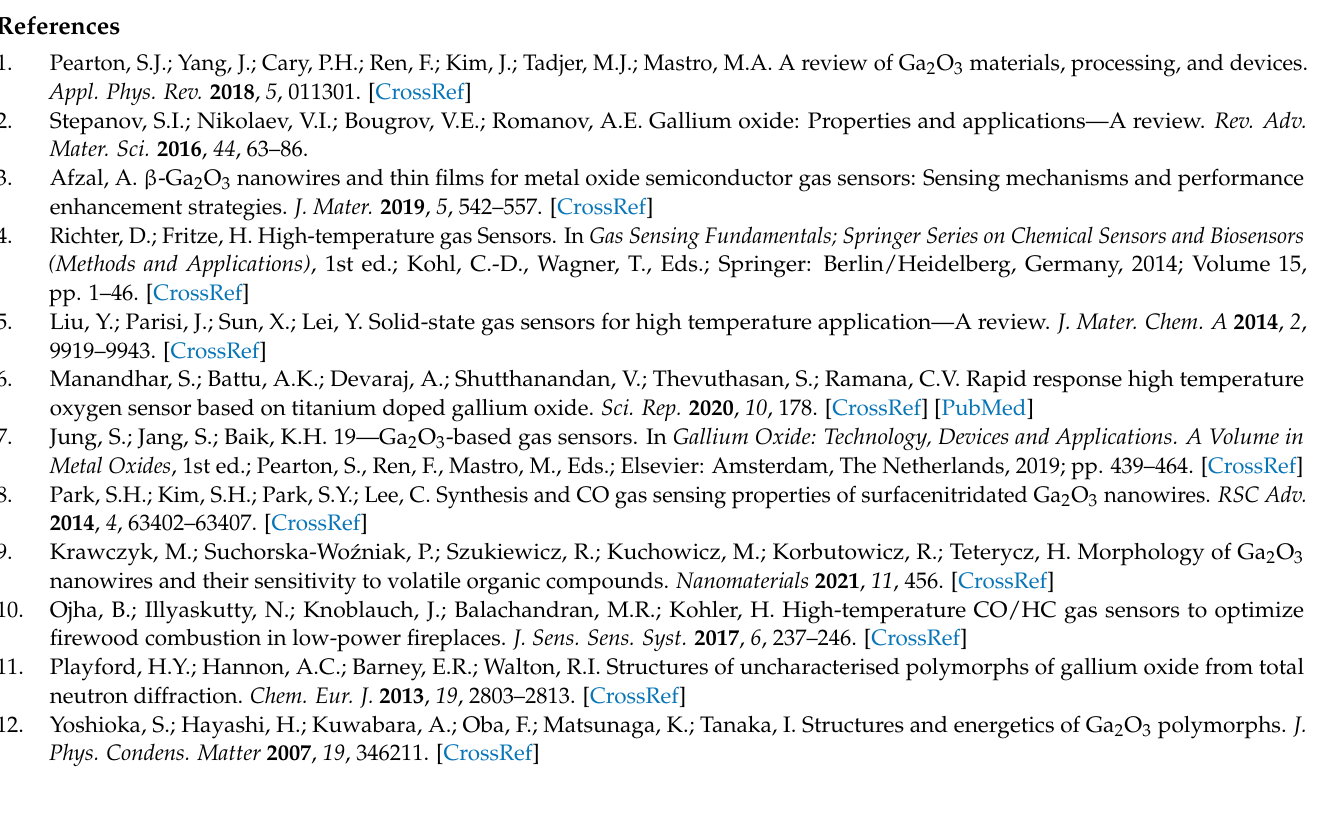
Figure S1: The XRD data of powders obtained by the interaction of gallium and tin salts solution with ammonia: (1) 0, (2) 1.1, (3) 4.3, (4) 7.0, (5) 13 at.% Sn. Gray vertical lines indicate ICDD GaOOH (6–180) data, Figure S2: MS data of gaseous products formed by the decomposition of precursor containing (a) 0 and (b) 13 at.% Sn, Figure S3: XRD patterns of Ga 2 O 3 (Sn), annealed at 500 ◦ C: (1)–0, (2)–1.10, (3)–4.3, (4)–7.0, (5)–13 at.% Sn. Vertical gray bars indicate positions and relative intensities of α -Ga ε -Ga 2 O 3 (ICDD card [43–1013]). The peaks of other phases (probable 2 O 3 ) are marked by (*), Figure S4: XRD patterns of Ga 2 O 3 (Sn), annealed at 750 ◦ C, Figure S5: XRD patterns of Ga 2 O 3 (Sn), annealed at 1000 ◦ C, Figure S6: O1s spectrum of Ga 2 O 3 (x = 0) annealed at 750 ◦ C and fractions of different spectral components for Ga 2 O 3 (Sn), annealed at different